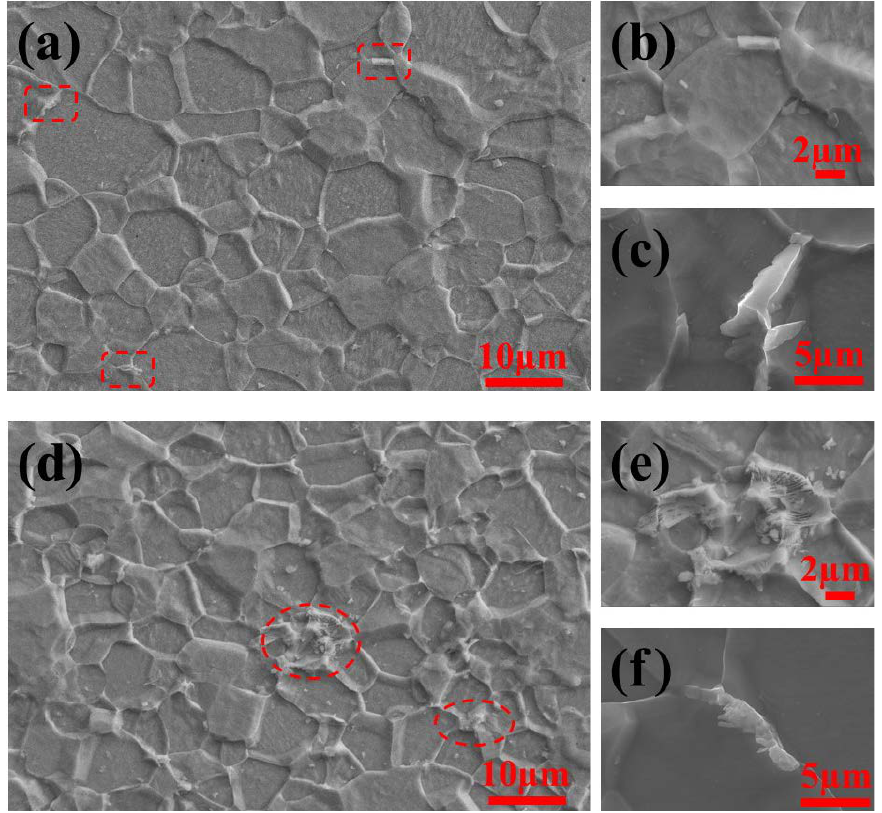
Figure 4. Distribution and morphology of cementite with different C content. ELC: ( a – c ); LC: ( d – f ). After the steel strips were corroded by the aqueous solution mixed with 10 g/L ammonium sulfate and 10 g/L citric acid, the particle size of precipitated particles obtained by filtration of the solution was analyzed by SAXS. The mass fraction distribution and mass density distribution under different particle sizes are obtained by SAXS, as shown in Figure 5. The mass fraction of less than 36 nm and >200 nm in ELC is greater than that of in LC, and the mass fraction of 36–200 nm is vice versa. The mass fraction is over 35% of in 140–200 nm, the mean size of ELC is 136.3 nm, which is slightly more than 131.4 nm of LC, mainly because the mass fraction above 200 nm in ELC is 118% more than that in LC (Figure 5a). The mass density distribution has the same law as the mass fraction distribution, and the highest mass density is between 1–5 nm.